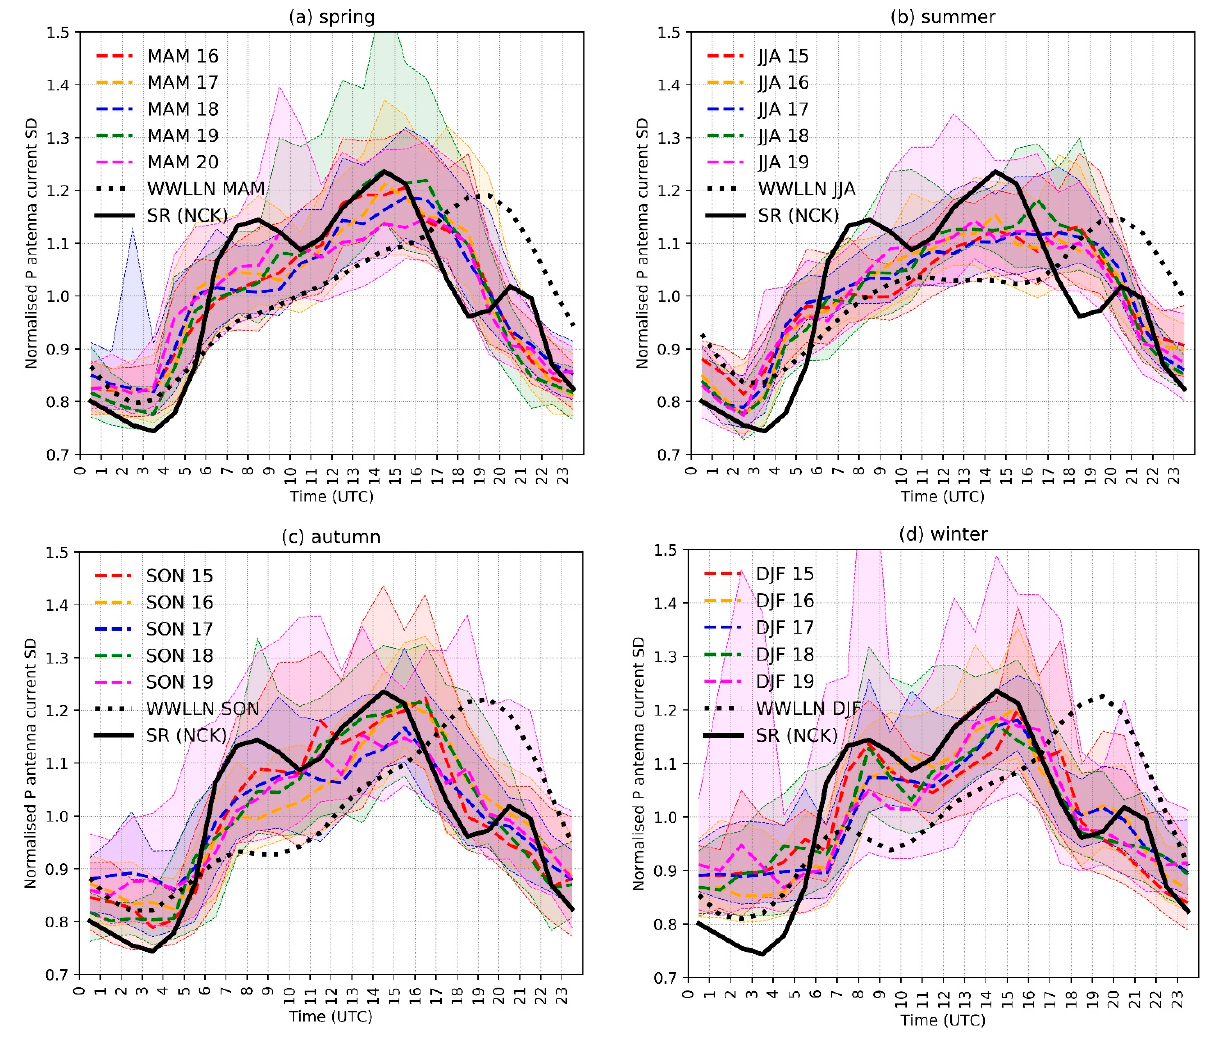
Figure 6. Seasonal diurnal variation (weekends) of the standard deviation of current induced on the BTD-300 primary antenna in the 10–45 Hz frequency range (1 June 2015–31 May 2020). The normalised 1-h resolution median lines (dashed) are superimposed to the interquartile range (shaded area). The observed trend is compared with the seasonal diurnal variation of global thunderstorms derived from WWLLN data (2012–2013) [32] (dotted) and the cumulative intensity of the first 3 SR modes measured at NCK observatory (1994–1998) [14], both normalised by the mean. Table 1. Annual and seasonal Pearson correlation coefficient between median diurnal variation of BTD primary antenna SD and SR cumulative intensity of the first 3 modes (NCK) [14], WWLLN global thunderstorms [32], Carnegie curve [17], respectively. Period BTD-SR